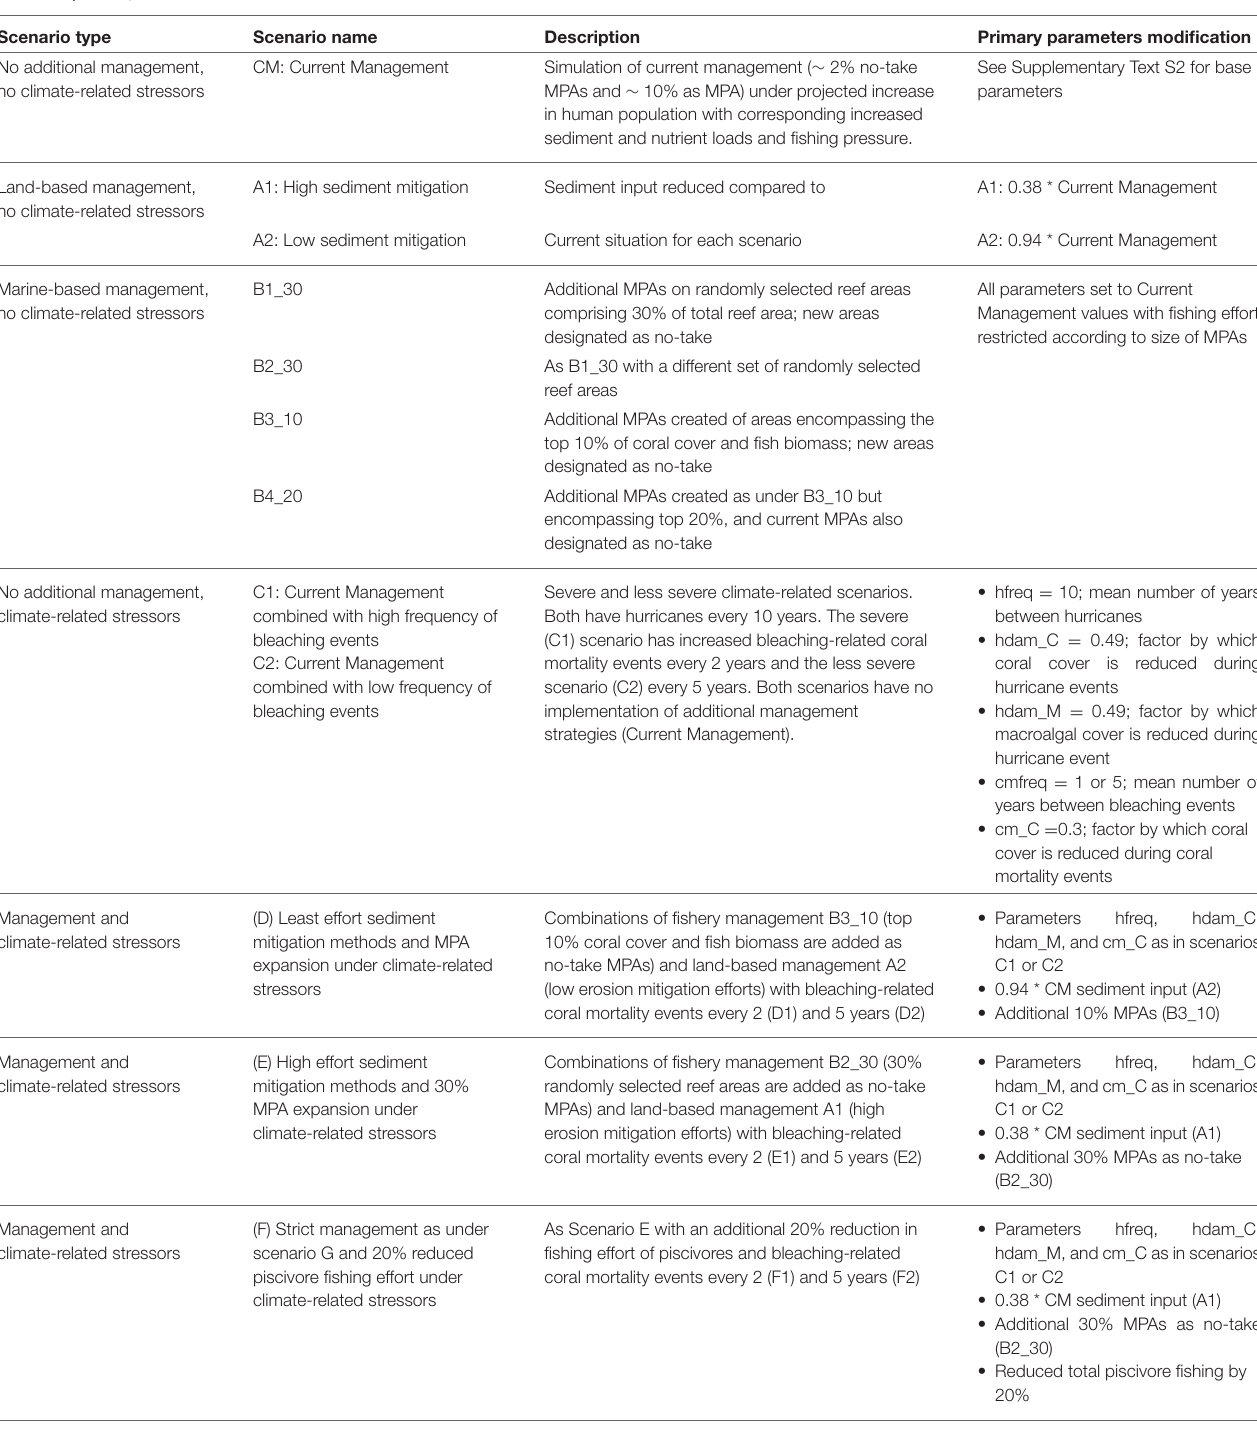
TABLE 2 | Descriptions of 16 forecast simulations from 2010 to